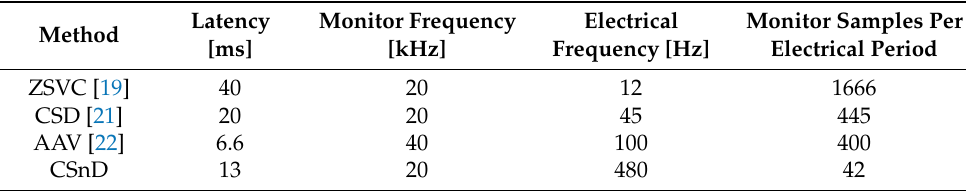
Table 3. FDI performances of the proposed algorithm compared with literature results.